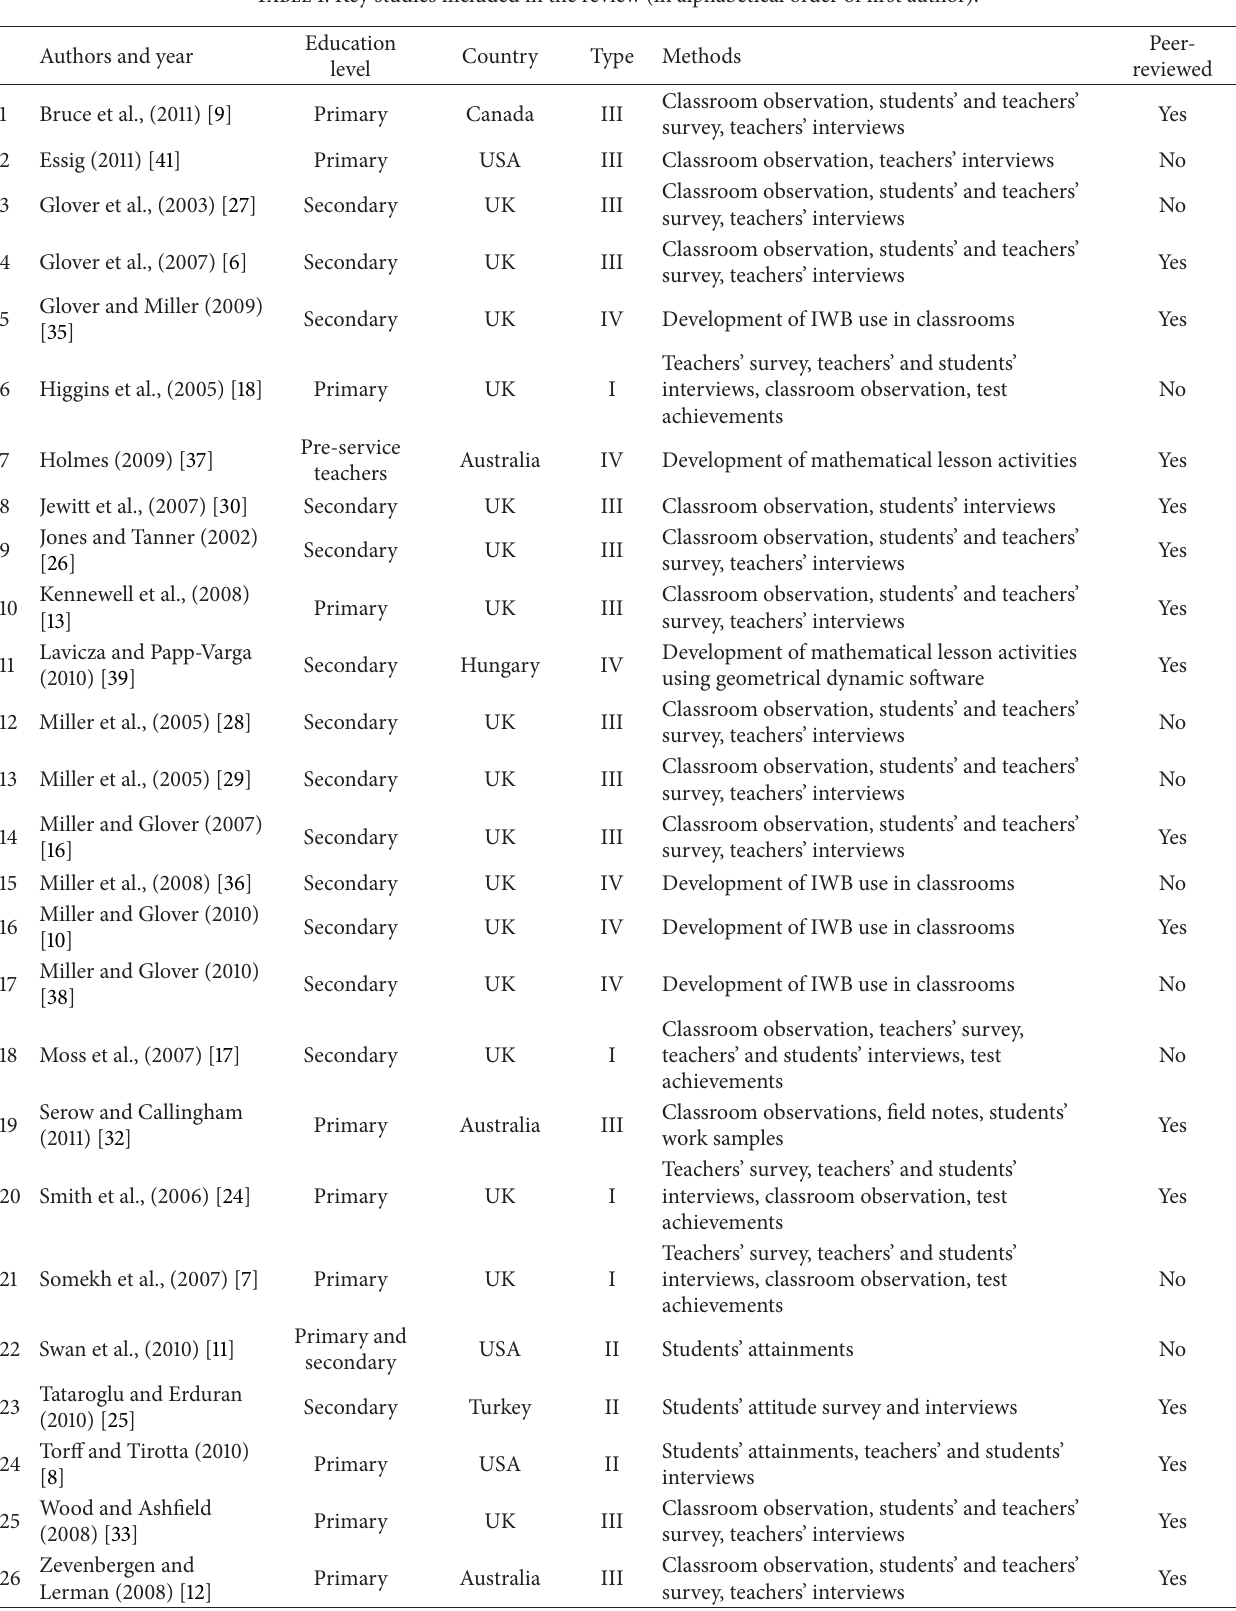
Table 1: Key studies included in the review (in alphabetical order of first author). Authors and